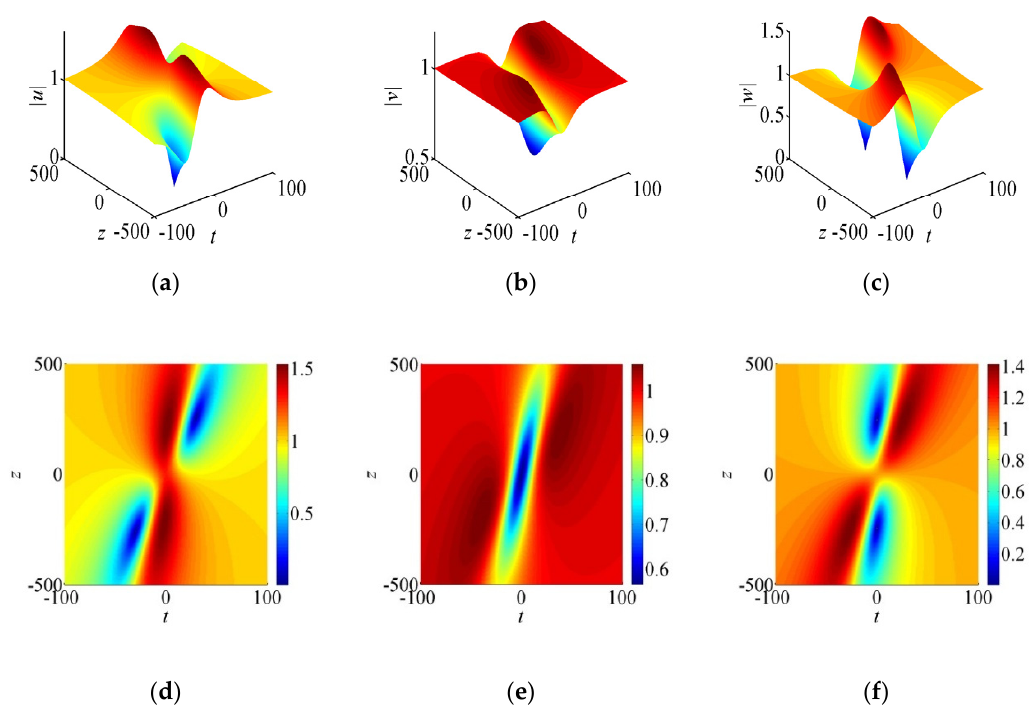
Figure 1. The rogue wave solution given by Equations (2) and (3) with ρ = 1, σ = 1, δ = 0.1 and Ω 0 = 0.0537 + 0.0537 i : ( a ) u ‐ component (bright FPRW); ( b ) v ‐ component (EDRW); ( c ) w ‐ component (FPRW); ( d ) the top view of ( a ); ( e ) the top view of ( b ); ( f ) the top view of ( c ).